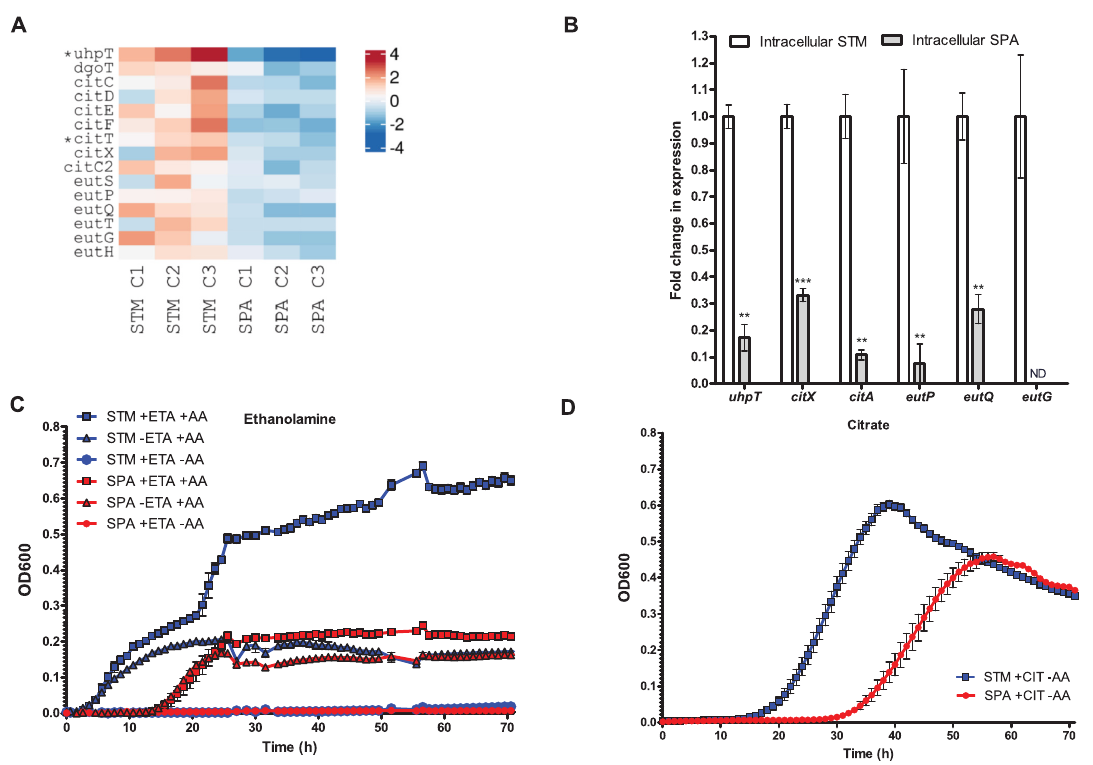
Fig 4. Differences in carbon utilization gene expression between STM and SPA. ( A ) Heatmap of carbon catabolism gene expression by intracellular STM vs. intracellular SPA. Pseudogenes in the SPA genome are marked with an asterisk. ( B ) The fold change in the transcription of the glucose-6P ( uhpT ), citrate ( citA and citX ), and ethanolamine ( eutP , eutQ and eutG ) utilization pathways in intracellular STM relative to their expression in intracellular SPA was determined using qRT-PCR. RNA was extracted from FACS- sorted intracellular salmonellae 8 h p.i. The mean and the standard error of the mean (SEM) of 3–8 independent qRT-PCR reactions are shown. Student’s t-test was used to determine statistical significance. �� , p < 0.01; ��� , p < 0.001; ND, not detected. ( C ) Growth of STM and SPA in M9 in the presence (+) or absence (-) of casamino acids (AA) and ethanolamine (ETA), under anaerobic conditions. ( D ) Growth of STM and SPA in M9 supplemented with citrate as a sole carbon source.